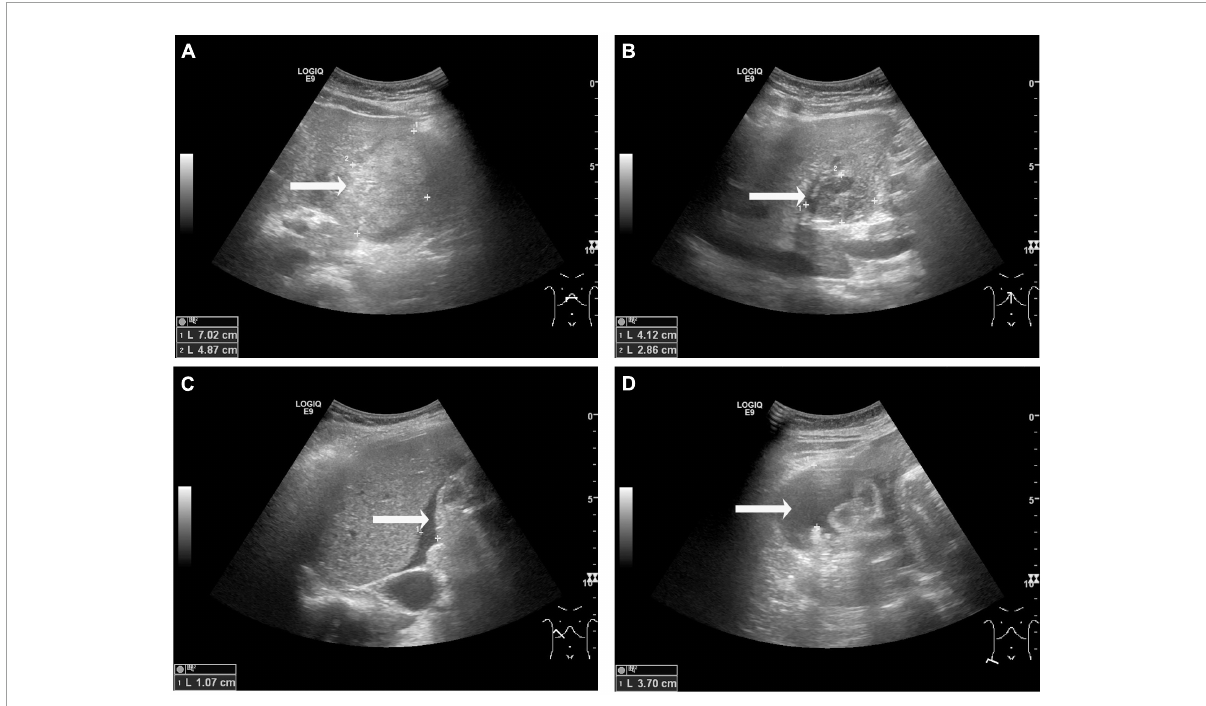
FIGURE1 Transabdominal ultrasound observations at admission. (A) A heterogenic area was observed on the visceral surface of the left hepatic lobe, measuring 7.0 cm × 3.8 cm × 4.9 cm (arrow). (B) A hypoechoic area was observed in segment III of the liver, measuring